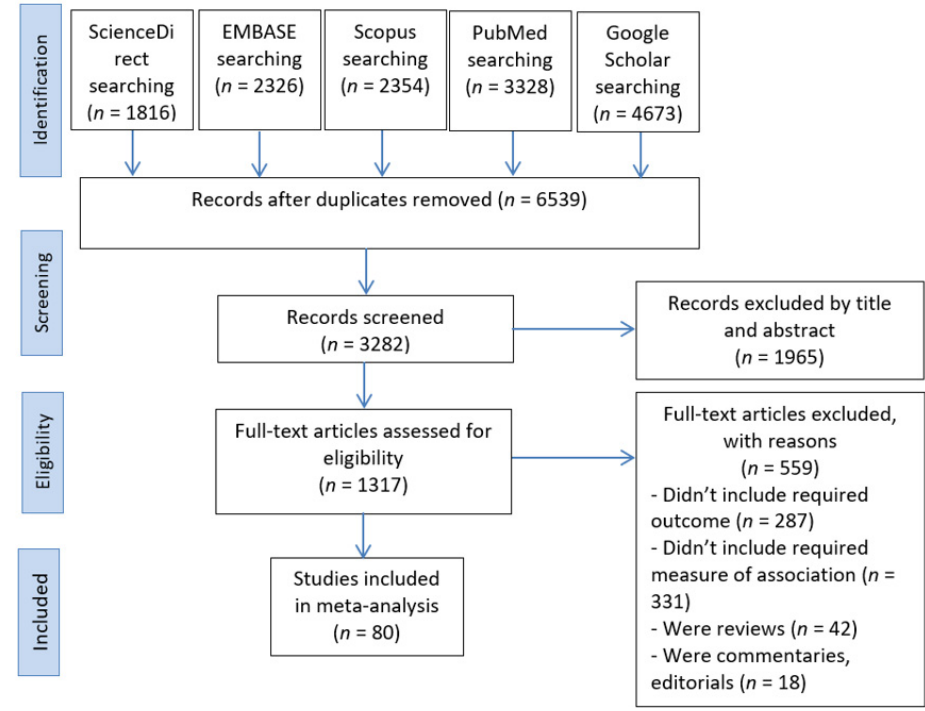
Figure 1. PRISMA flow chart of study identification and study selection process.